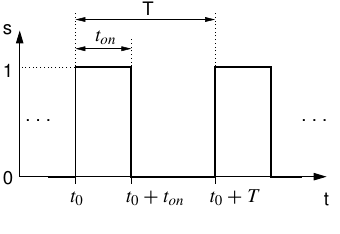
Figure 3. Duty cycle of the DC-DC